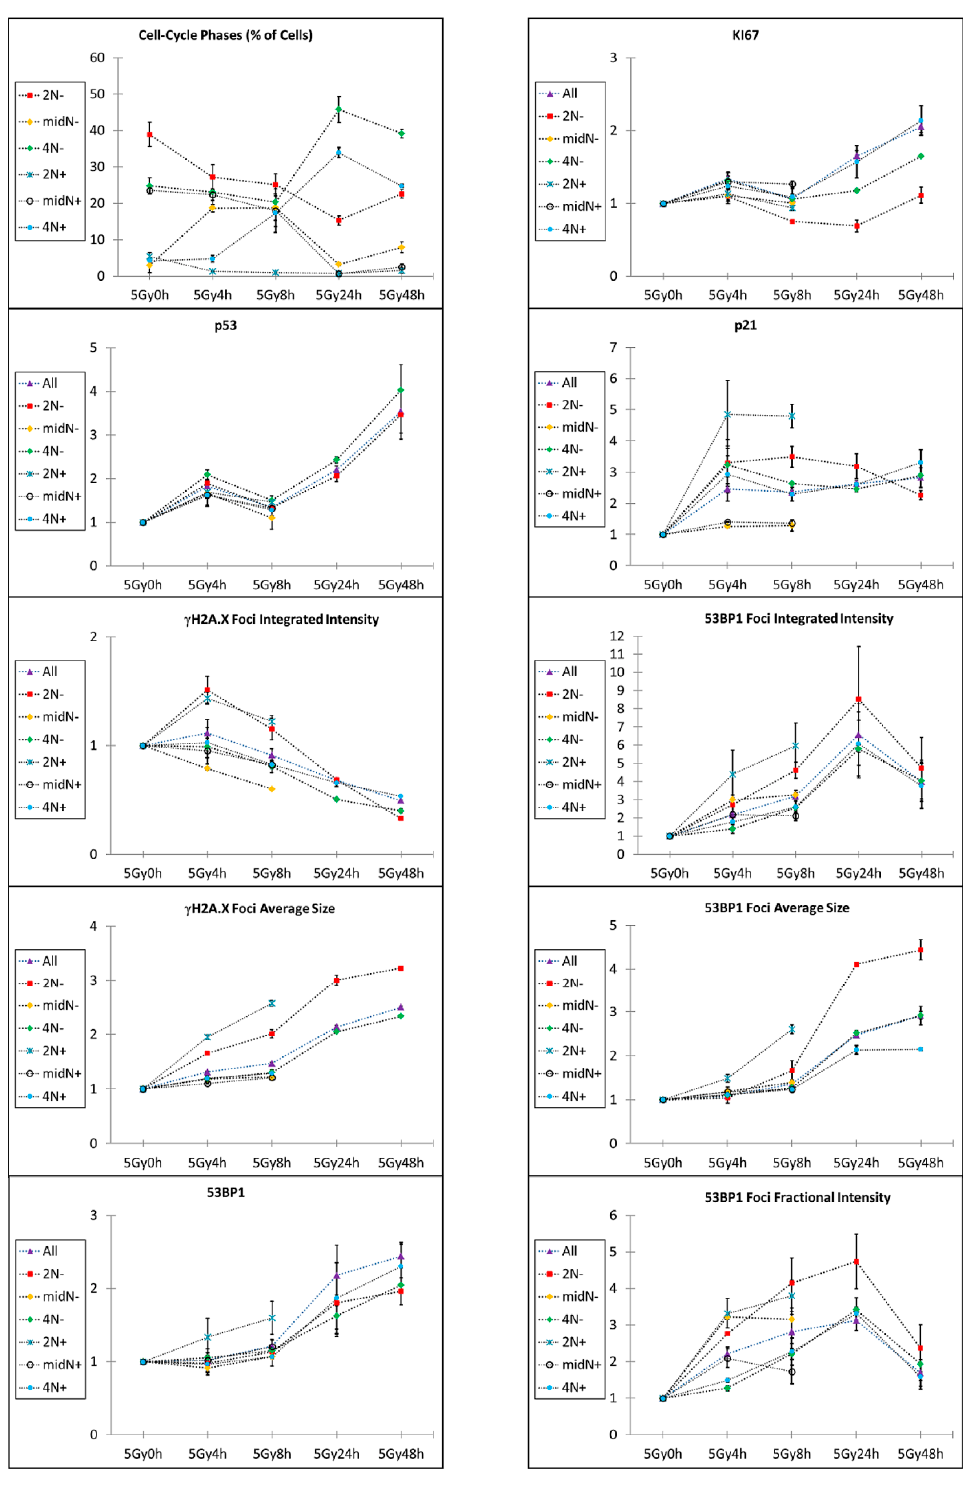
Figure 4. Cell-cycle analysis of the checkpoint protein content and DDR-related parameters after 5Gy irradiation. Statistical analysis of the indicated parameters calculated by targeting selected subpopulations according to their cell-cycle position at the irradiation (EdU+ and − ) and at the selected time-point (DNA content: 2N, midN, 4N). The adopted regions are indicated in Figure 1. At the later time-points, some cell-cycle fractions were not indicated due to their low representativeness (number of events less than 500) caused by the cell-cycle arrest.